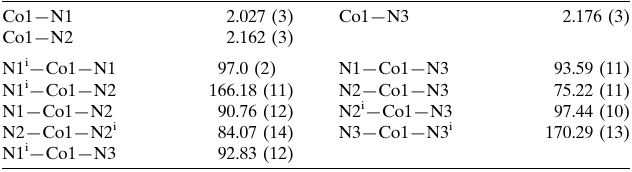
Selected geometric parameters (A˚ , (cid:4) ).